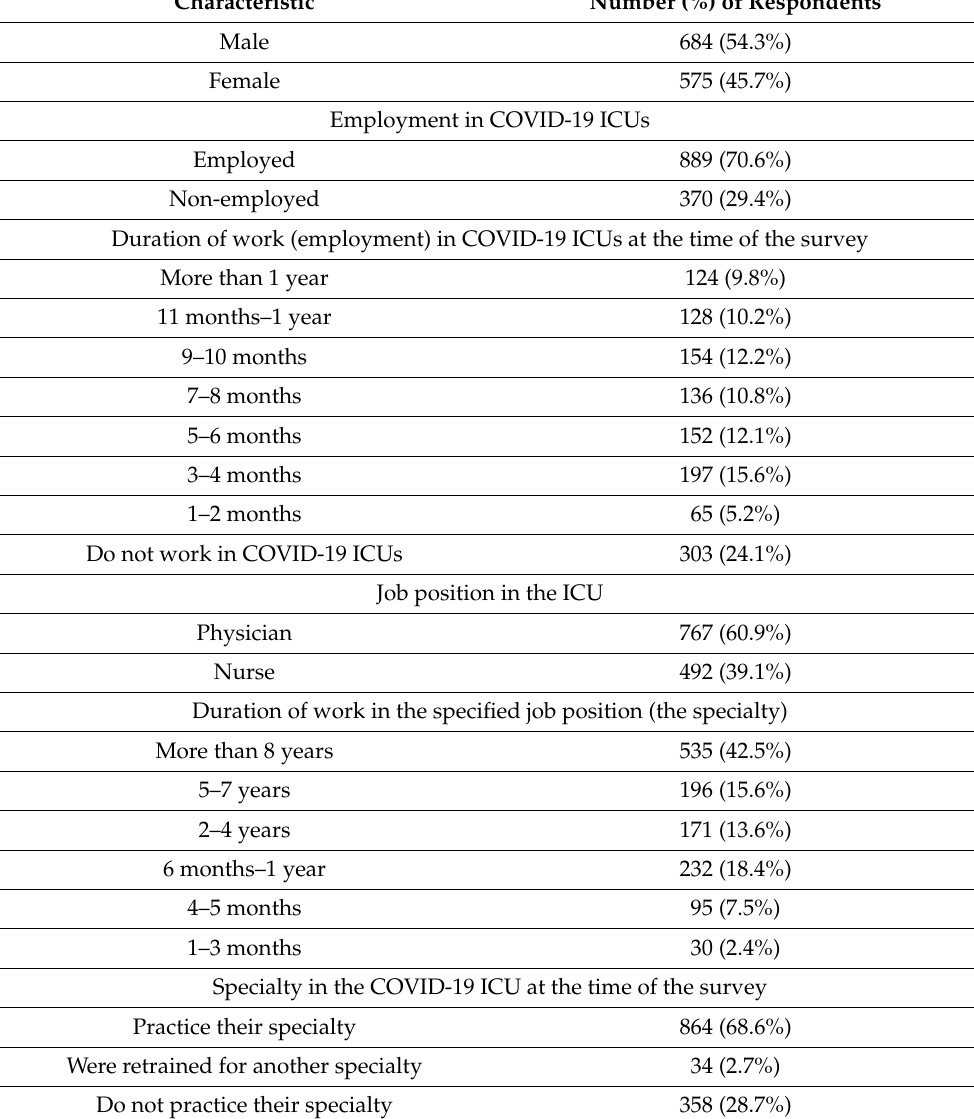
Table 1. General information about the